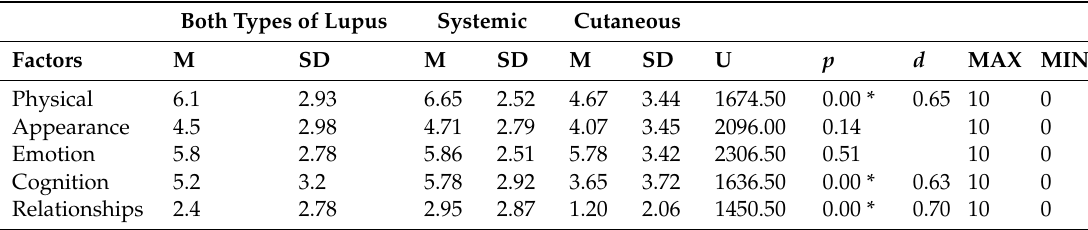
Table 3. Descriptive factor results for both types of